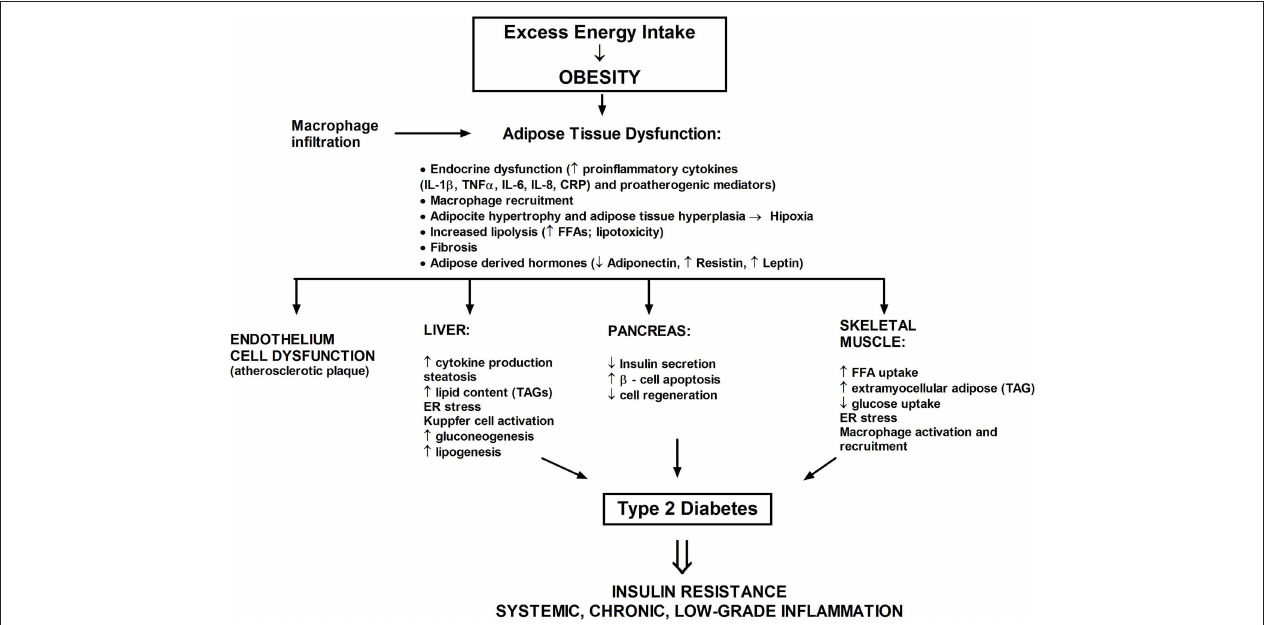
FIGURE 4 | The excess saturated fatty acids dysregulate a white adipose tissue homeostasis and lead to the development of metabolic stress. A chronic state of inflammation cause infiltration of adipose tissue by macrophages and local insulin resistance. Adipose tissue also serves as an endocrine organ whereby proinflammatory mediators reach the nonadipose tissue such as liver, muscle, or